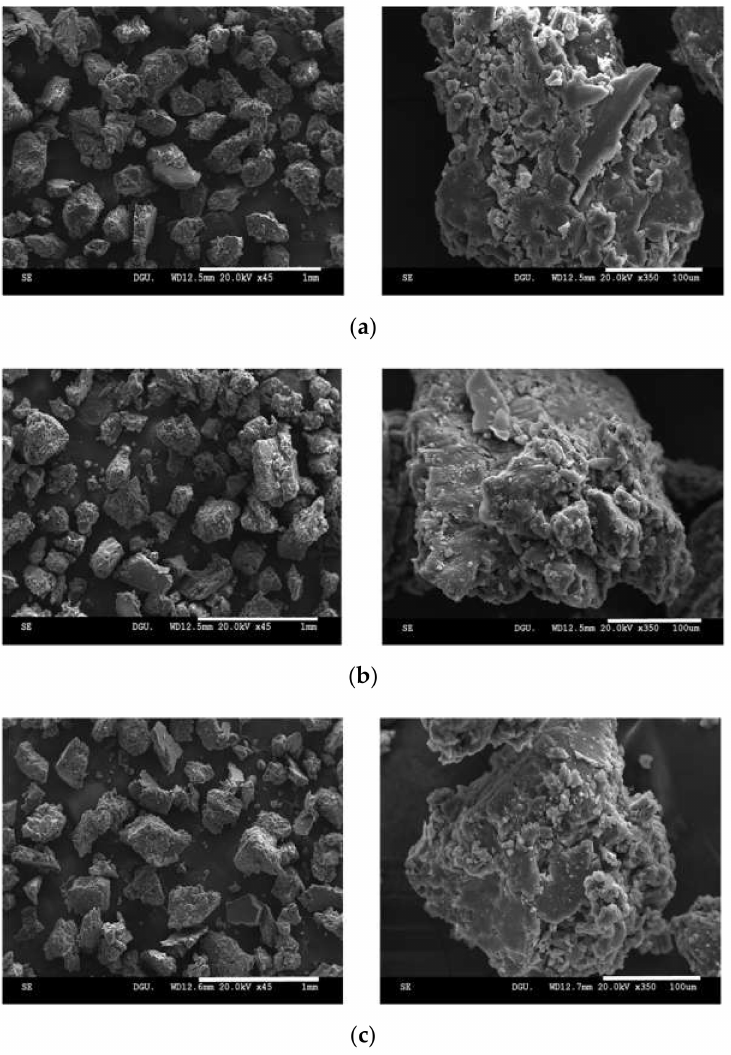
Figure 9. Morphology of SD-F4 on Day 0 ( a ) and after three months of storage at 4 ◦ C ( b ) and 25 ◦ C ( c ). The scale bar on the left panel is 1 mm, and the scale bar on the right panel is 100 µ